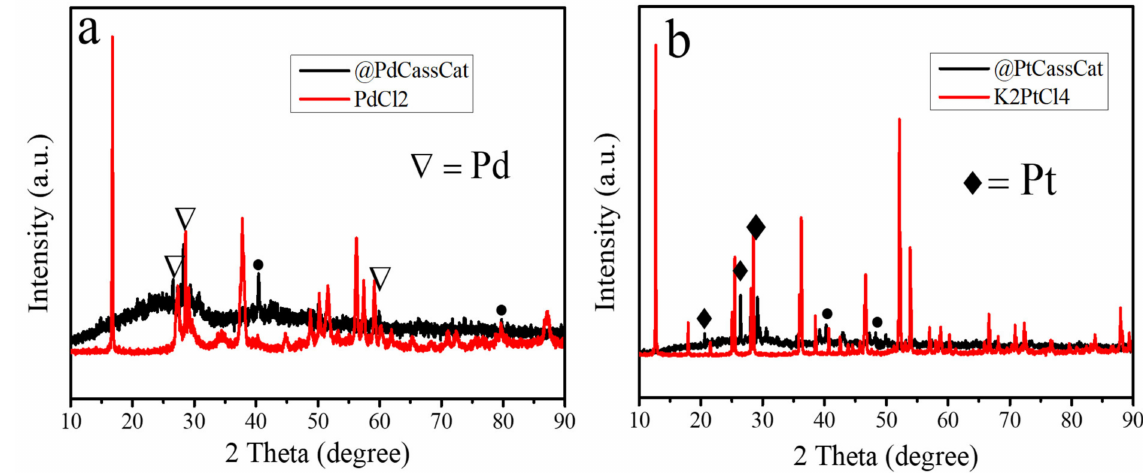
Figure 6. pXRD diffraction patterns of ( a ) @PdCassCat and PdCl 2 and ( b ) @PtCassCat and K 2 PtCl 4